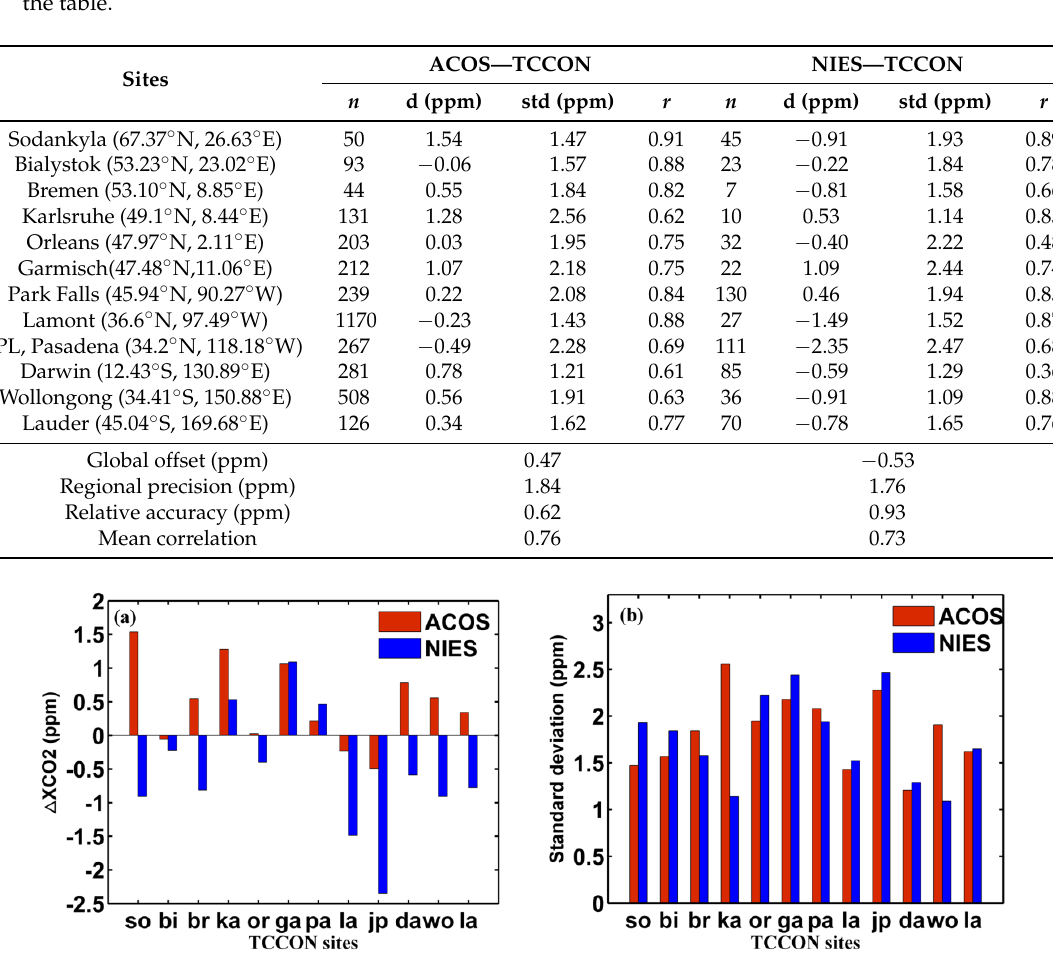
Figure 1. The column averaged dry air mole fractions of atmospheric carbon dioxide (XCO 2 ) bias ( a ) and standard deviation ( b ) of the Atmospheric CO 2 Observations from Space (ACOS) and the National Institute for Environmental Studies (NIES) versus Total Carbon Column Observing Network (TCCON) observations listed in Table 1. The TCCON sites are arranged from high to low latitude.